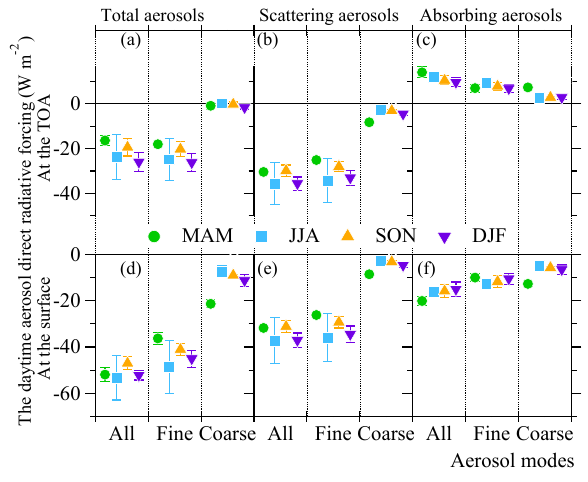
Figure 12. Seasonal variations of the clear-sky aerosol direct radia- tive forcing (DRF, Wm − 2 ) at both TOA (a–c) and the surface (d–f) . The DRFs of the total (a, d) , scattering (b, e) and absorbing (c, f) aerosols in the all, fine and coarse modes are all investigated in ur- ban Nanjing.